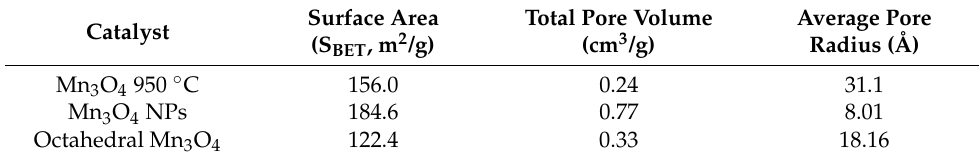
Table 1. Surface area, pore volume and pore radius of a series of manganese oxides.